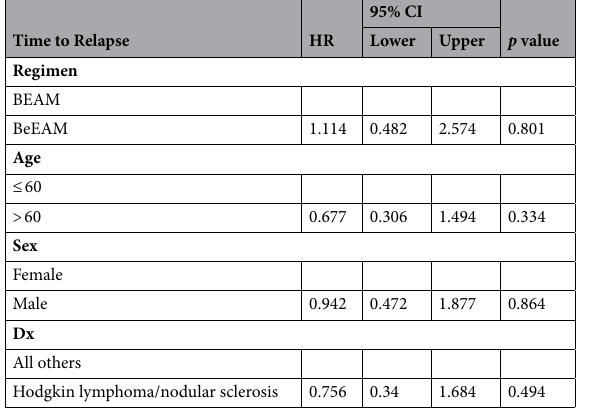
Table 5. Progression-free survival: multivariate Cox regression